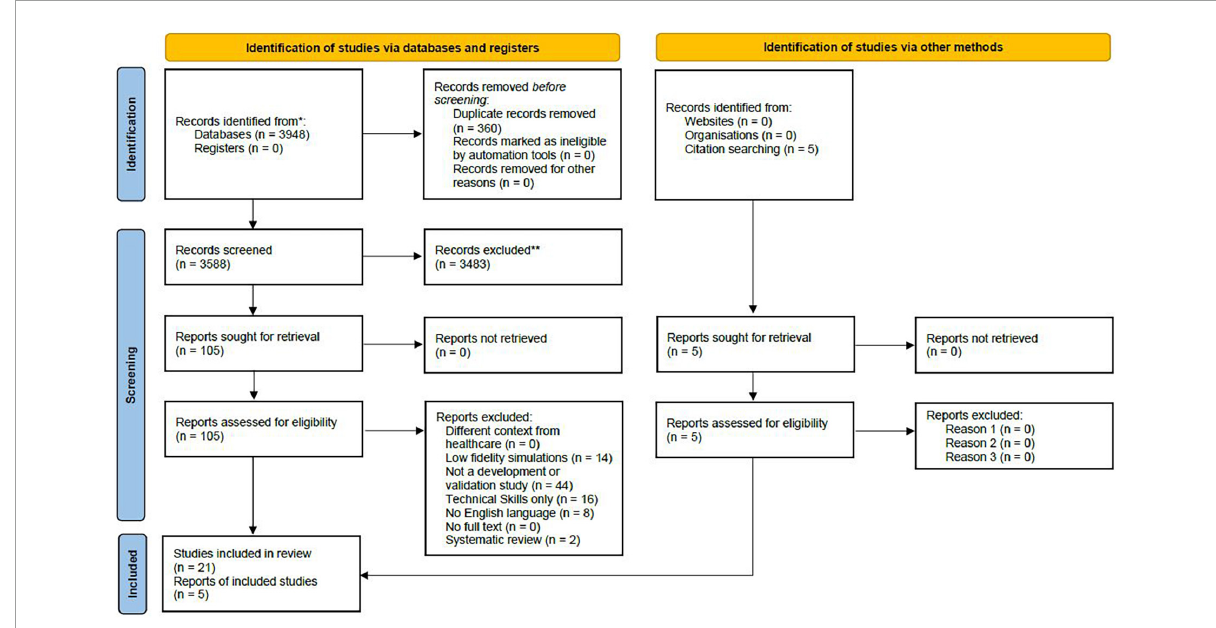
FIGURE1 PRISMA Flow diagram of article screening and selection